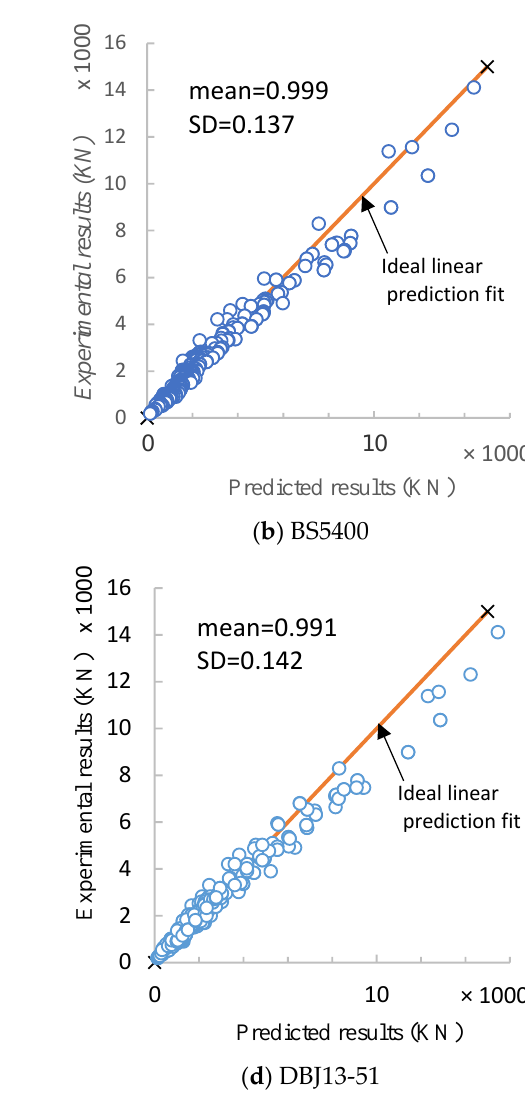
Figure 8. Performance of the second proposal of the standard formulations.